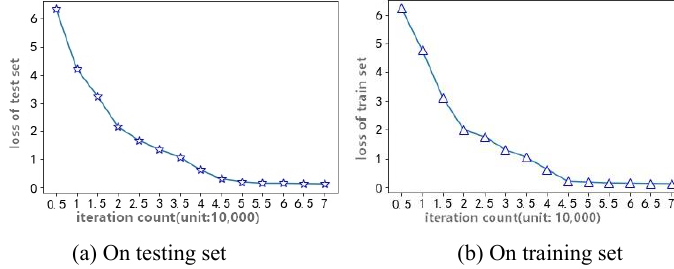
Fig.3. Convergence of loss